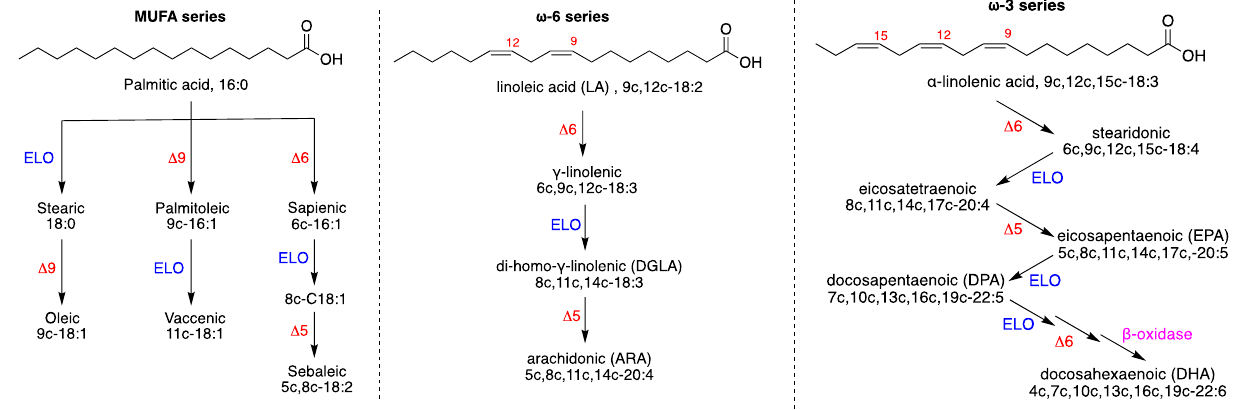
Figure 1. Formation of unsaturated fatty acids: ( left ) biosynthetic pathways of MUFA starting from palmitic acid (SFA); ( center ) the omega-6 PUFA biosynthesis starting from linoleic acid; ( right ) the omega-3 PUFA biosynthesis starting from alpha-linolenic acid. Enzymes: ELO elongase; Δ5-, Δ6-, and Δ9-desaturase; β-oxidase. Numerical abbreviations describing the position and geometry of the double bonds (e.g., 9c), the notation of the carbon chain length and total number of double bonds (e.g., C18:2); in parenthesis, the used acronyms (e.g., ARA for arachidonic acid). Reprinted from Ref. [10]. Copyright year 2022, Ferreri et al.